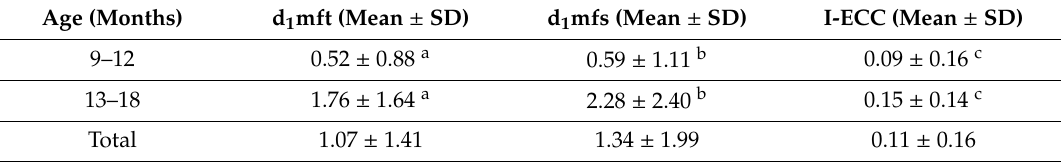
Table 2. The mean of d 1 mft, d 1 mfs, and I-ECC indices according to the age